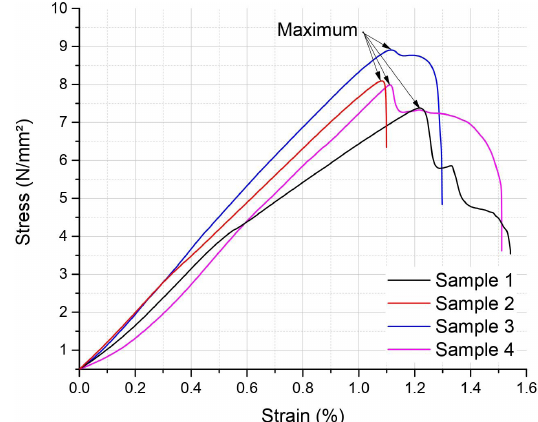
Figure 8. Flexure results of reinforced concrete beams (Samples 1 to